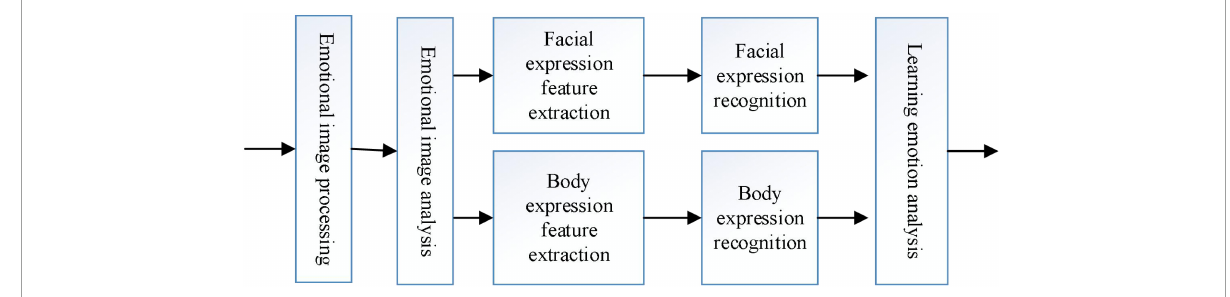
FIGURE4 Structure of the emotion model.